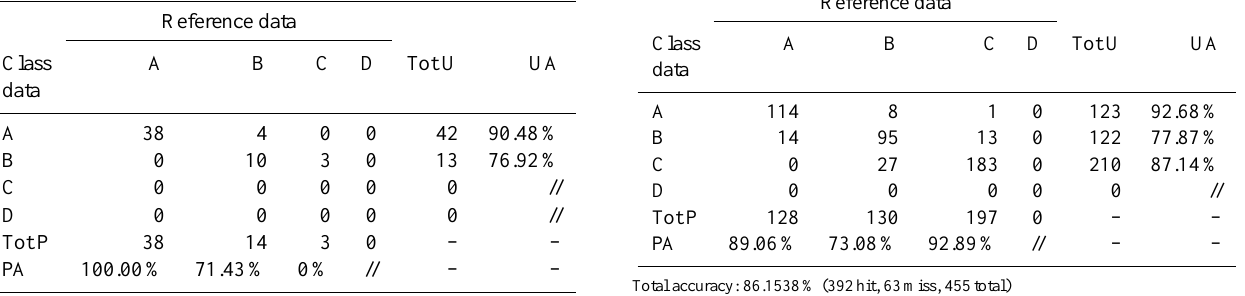
Table 8. Confusion matrix for the radial basis function network classifier evaluated on the test set TeS (cid:127) with elevation between 1600 and 1900m; Class A: absence of snow cover, Class B: 1– 10cm, Class C: 11–90cm, Class D: greater than